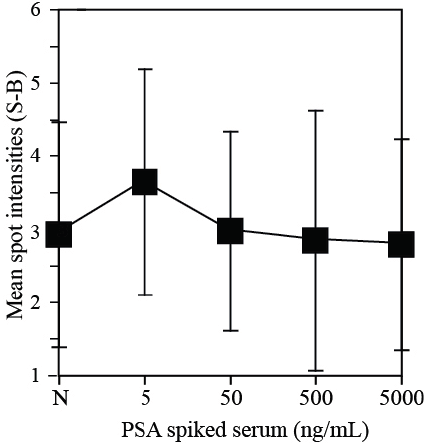
Figure 6. Cross-reaction tests of hK2 antibody spots against PSA spiked serum. Immunoassay signal of negative control (female serum sample) was compared with four PSA-spiked serum samples (5, 50 and 500 ng/mL and 5 µg/mL). HK2 capture antibody was spotted on P-Si chips at a concentration of 100